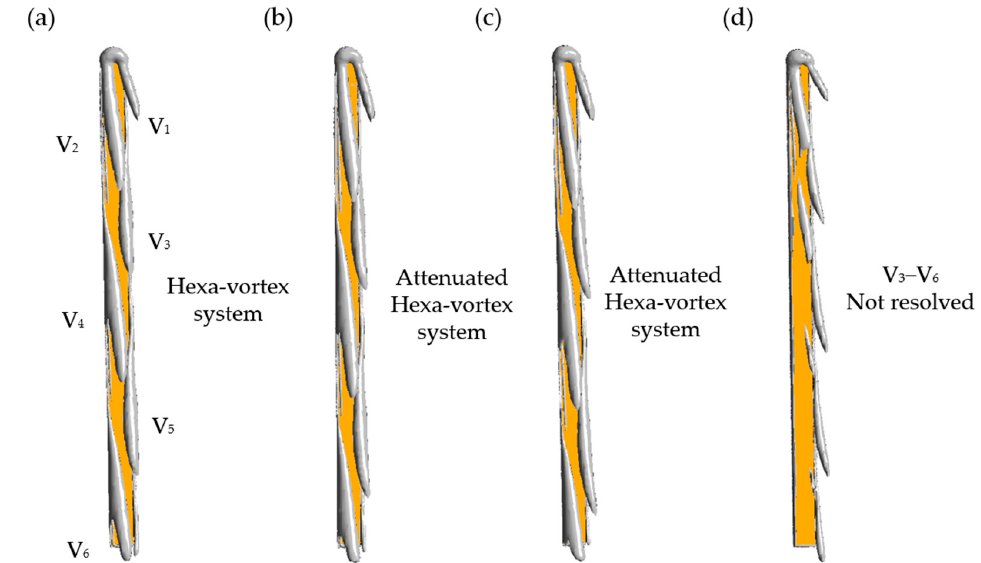
Figure 6. Three-dimensional vortex structure under different C L constraints: ( a ) C L > 0.8, ( b ) C L > 0.7, ( c ) C L > 0.6, ( d ) C L > 0.5. V: vortex. The iso-surfaces are outlined by dimensionless Q = 0.7. The ski is labeled by the yellow region.